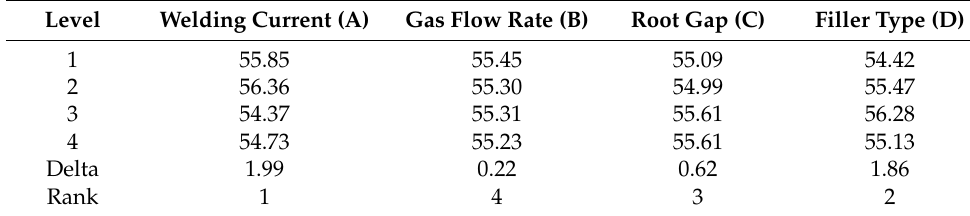
Table 17. Response table for signal-to-noise ratios of Flexural Strengths (larger is